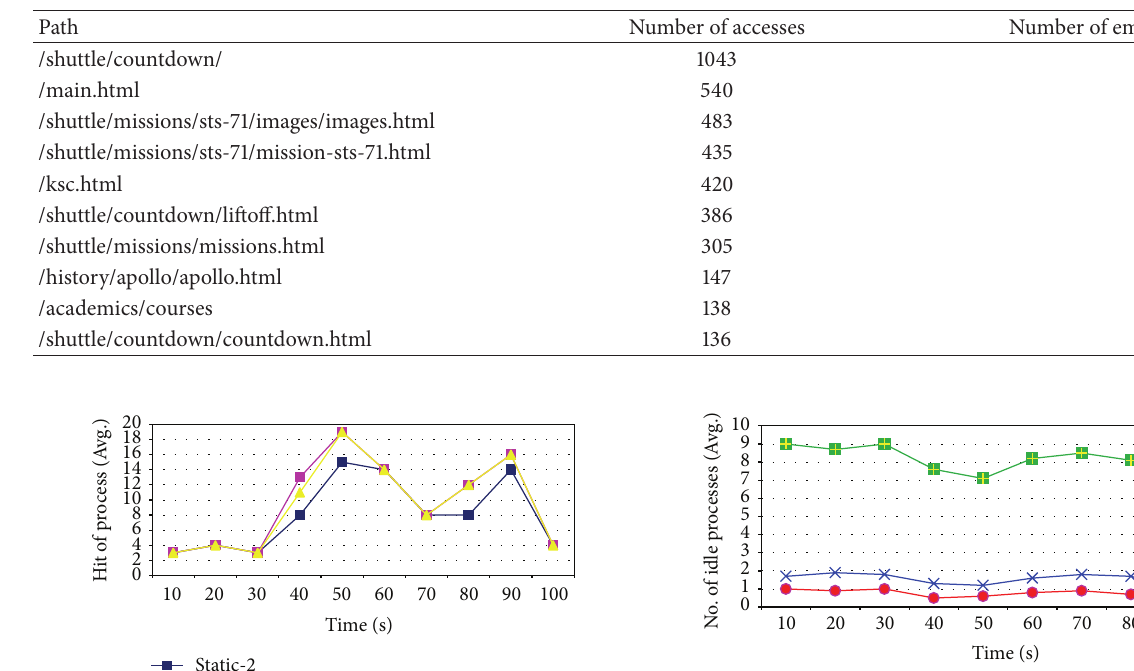
Table 5: Analysis of web objects (NASA).